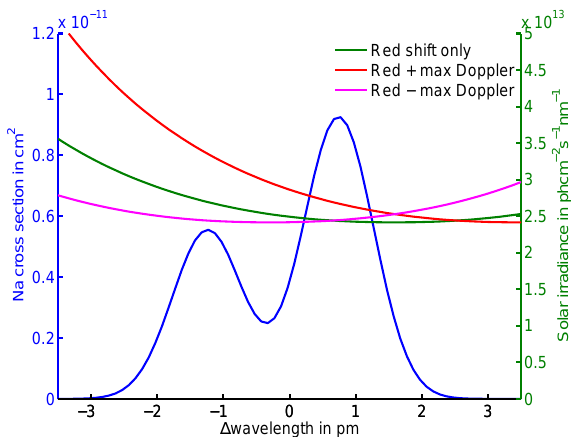
Figure 2. Absorption cross section for the D 2 line at temperature T = 220K (blue) and solar irradiance spectrum for different shifts. Both are used in high resolution to calculate the emissivity γ (Eq. 2) and attenuation factor f (Eq.